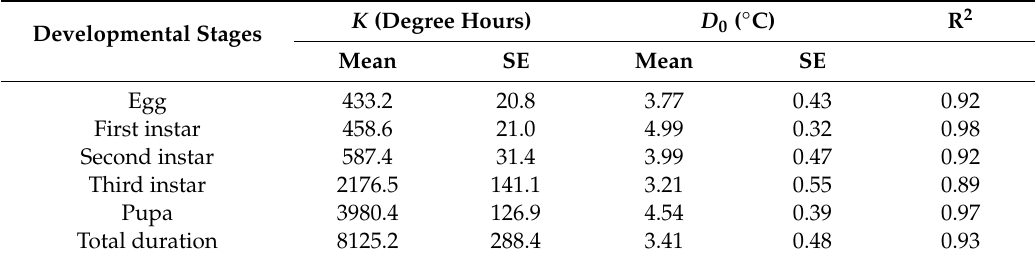
Table 3. Mean ( ± SE) of developmental threshold temperatures ( D 0 ) and thermal summation constants ( K ) for six developmental stages and the total developmental period of A. grahami , and the coe ffi cient of determination (R 2 ) of thermal summation models.